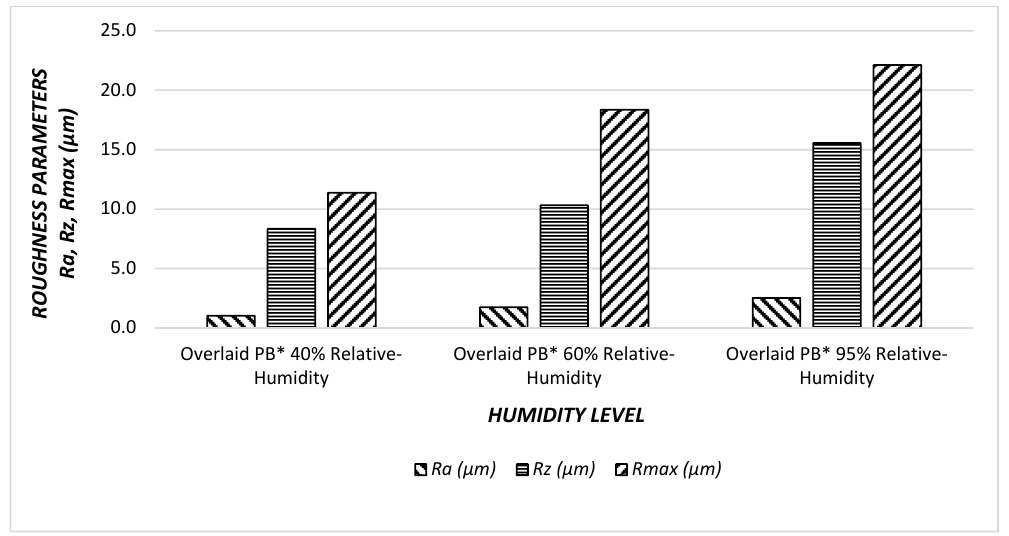
Figure 9. Surface roughness values (R a , R z , R max ) of the overlaid particleboard (O*-PB) under effect of humidity.